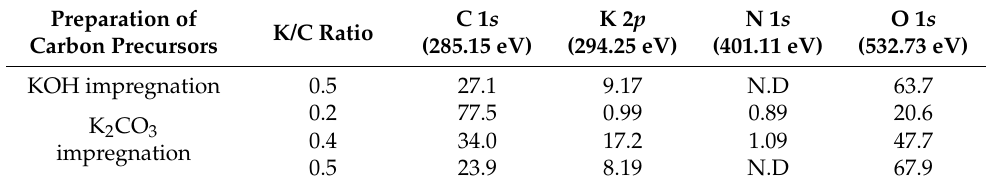
Table 1. XPS survey analysis of the KOH/K 2 CO 3 -impregnated carbon precursors.